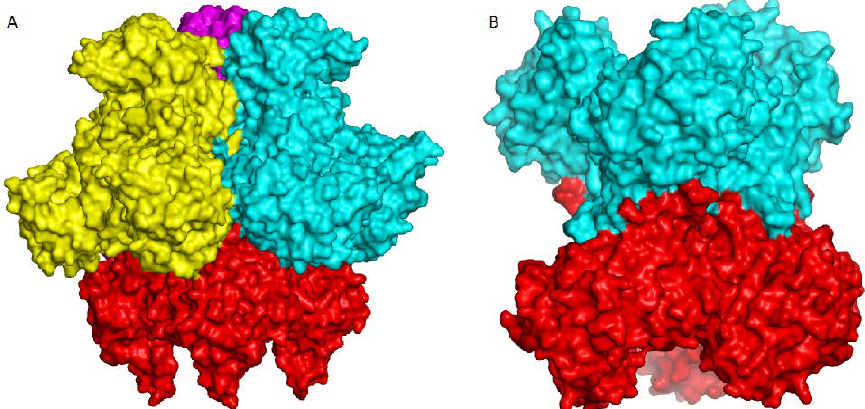
Figure 9. Higher oligomer structure of OTCase. ( A ) Pyrococcus furiosus OTCase showing tetrahedral arrangement of four catalytic trimers with concave faces outward; ( B ) Lactobacillus hilgardii OTCase shown the hexamer structure with convex faces interacting with each other. Different catalytic trimers are shown in different